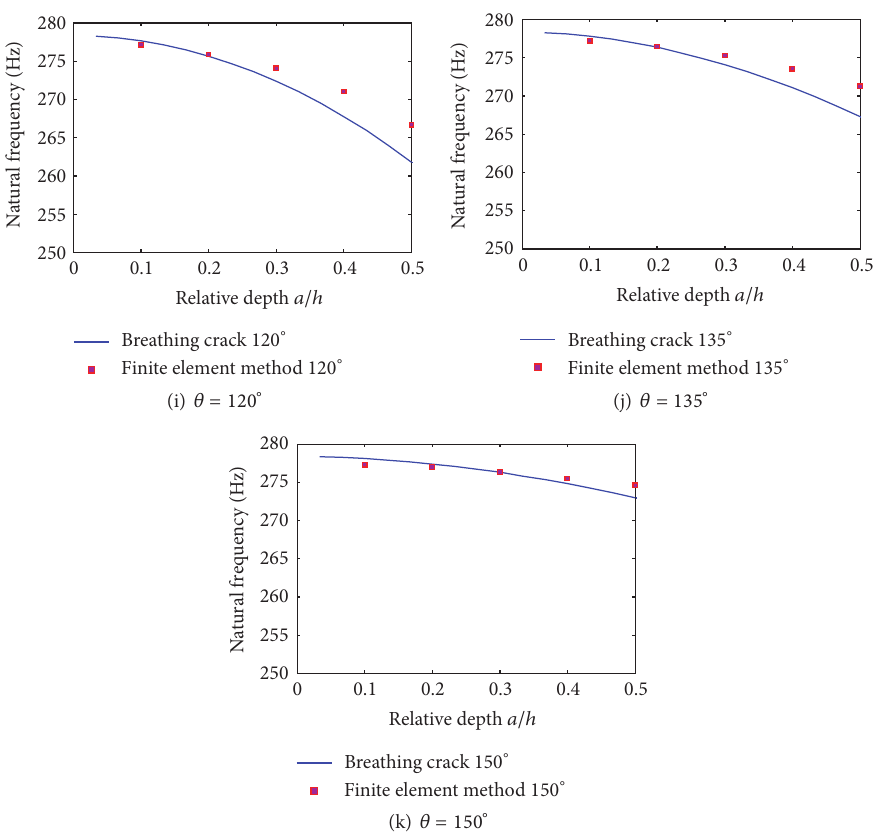
Figure 10: Natural frequencies obtained using the theoretical method and the ABAQUS FEM